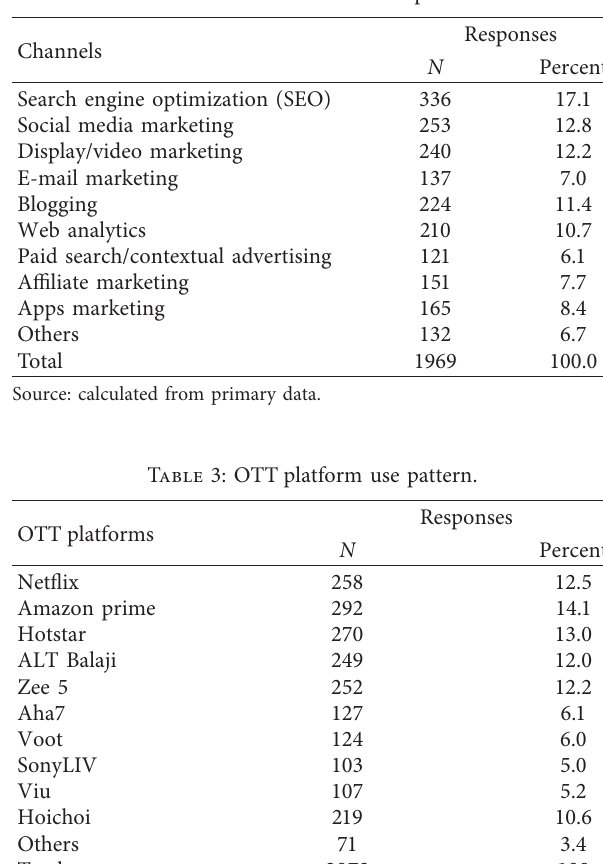
Table 2: DMM channel uses pattern.